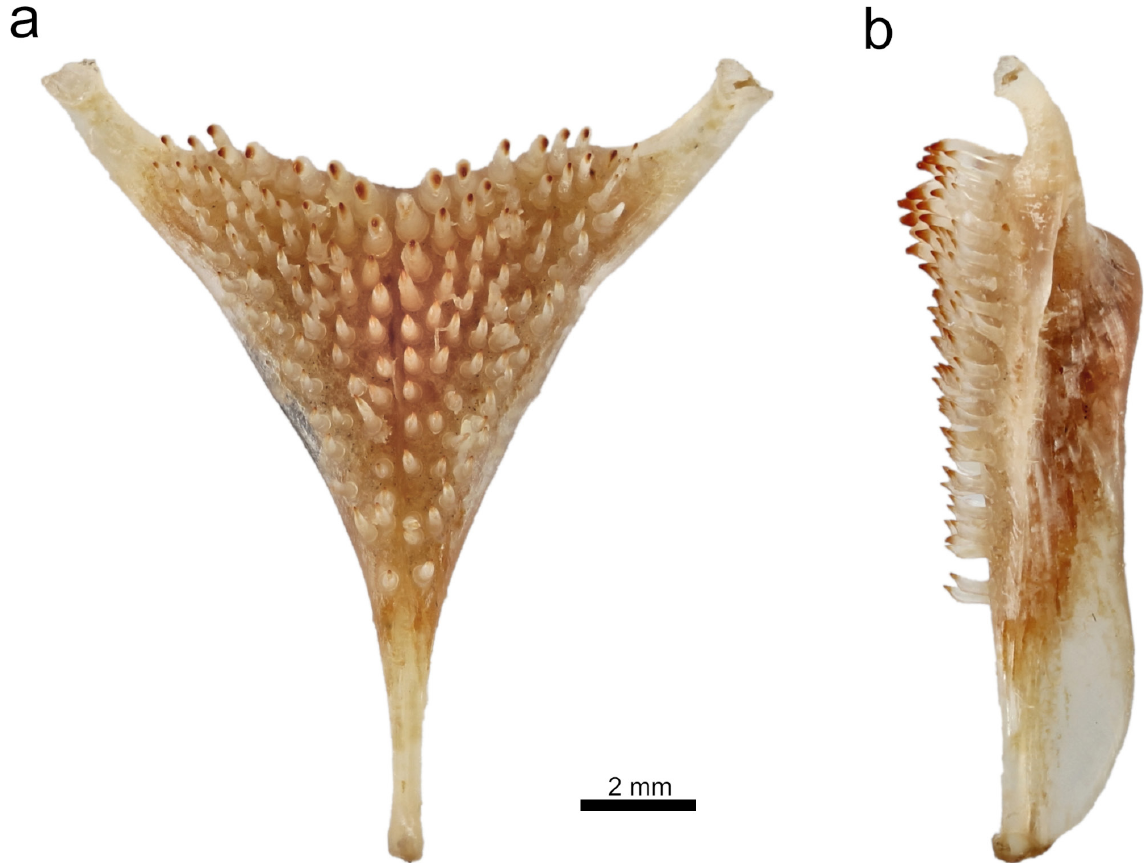
Fig. 22. Haplochromis aquila sp. nov. (RMCA 2018.008.P.0356; 122.9 mm SL). a . Dorsal view of the lower pharyngeal jaw. b . Lateral view of the lower pharyngeal